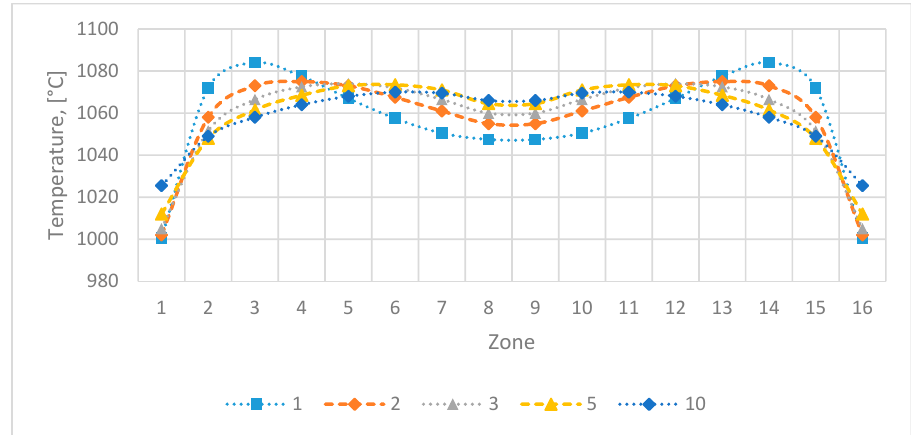
Figure 11. The temperature distribution in the zones of the furnace at M Total = max ( q total = min) with a variable rate of recirculation of furnace gases with minimum thermal power.